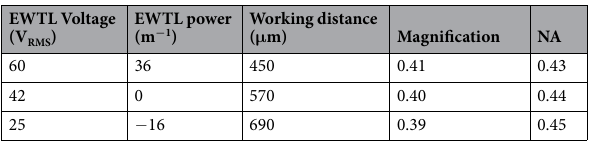
Table 1. 2P-FCM Zemax model optical parameters for different EWTL